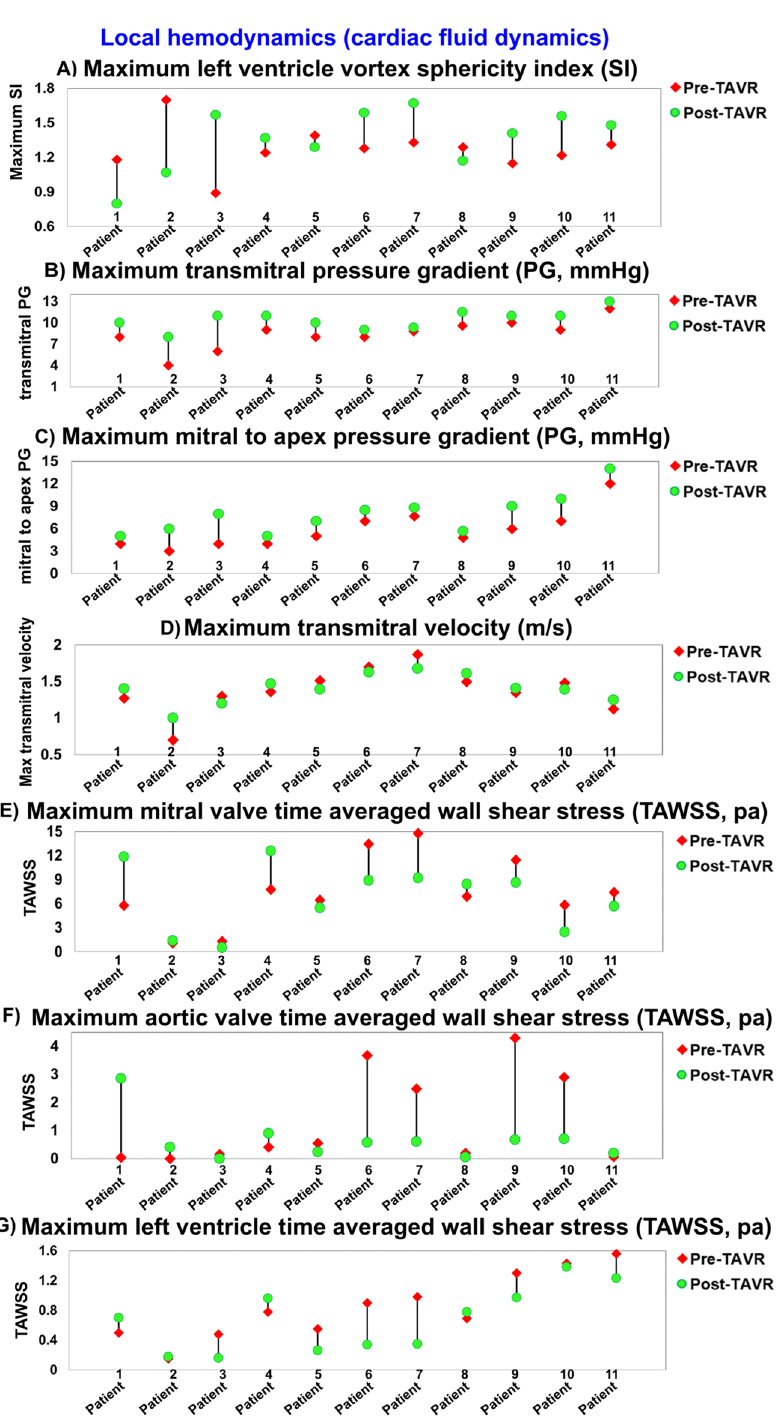
Figure 7. Changes in local hemodynamics (cardiac fluid dynamics) in patients between baseline and 90-day post-TAVR (N = 11). ( a ) Maximum left ventrcile vortex sphericity index; ( b ) Maximum transmitral pressure gradient; ( c ) Maximum mitral to apex pressure gradient; ( d ) Maximum transmitral velocity; ( e ) Maximum mitral valve TAWSS; ( f ) Maximum aortic valve TAWSS; ( g ) Maximum left ventricle TAWSS. Local hemodynamics : cardiac fluid dynamics, e.g., details of the instantaneous 3-D flow and vortex